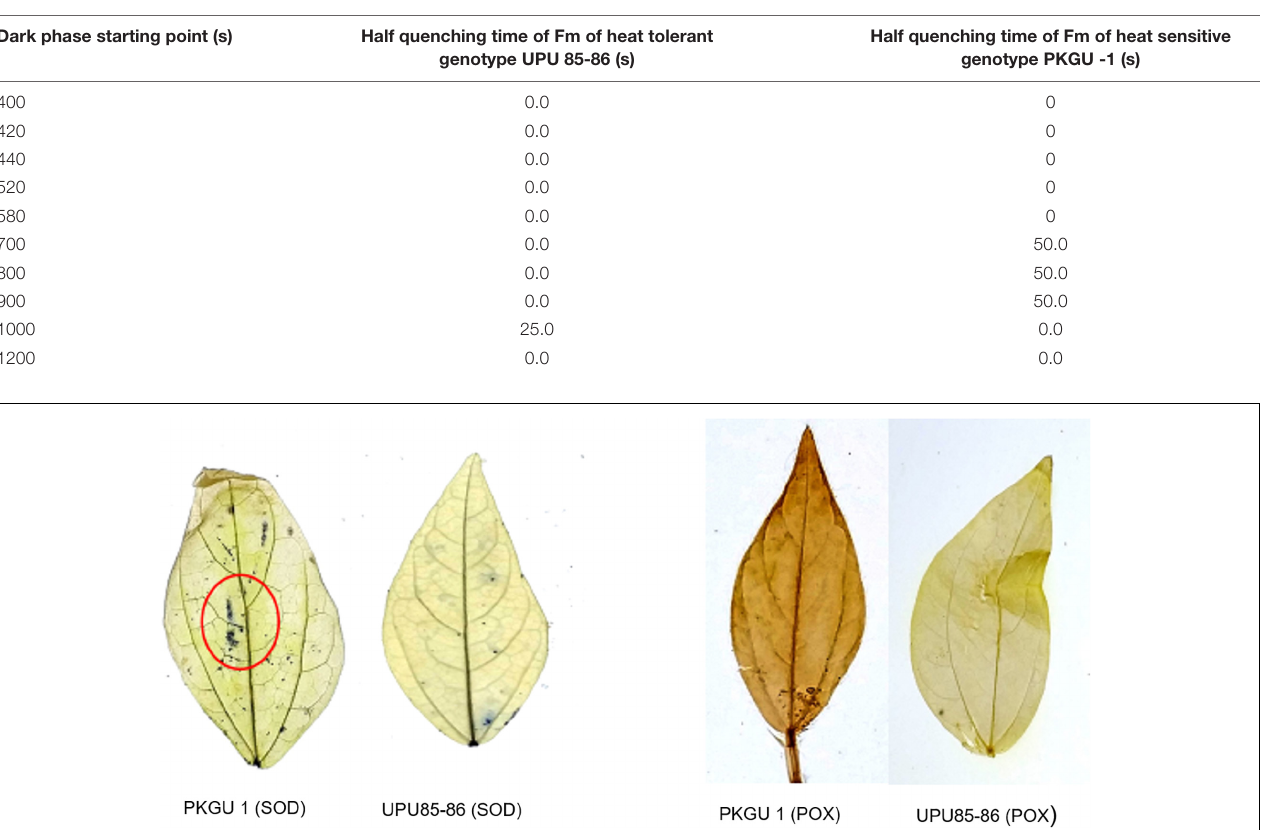
GGE biplot analysis identified most stable genotypes over the locations for